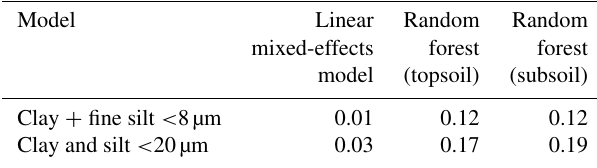
Table A2. Summary table of R 2 for the different models (linear mixed-effects model and random forest) for the two different explanatory variables ( < 8 and < 20µm) for all samples ( n = 1601), topsoil (0–20cm; n = 791) and subsoil (20–50cm; n =